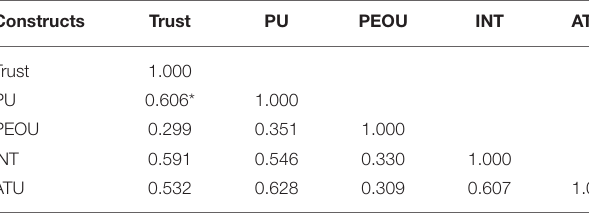
TABLE 5 | Discriminant validity results ( N =